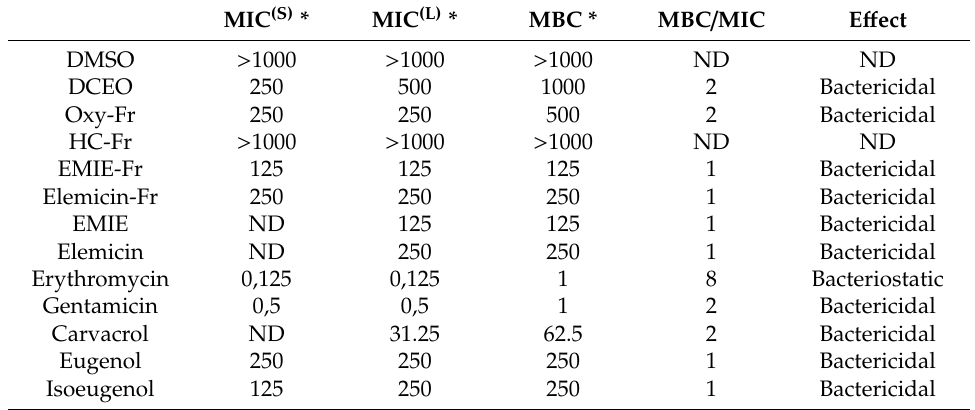
Table 1. Susceptibility and type of antibacterial e ff ect of the DCEO, the DCEO fractions, and synthesized molecules against the C. jejuni F38011 strain. Data resulted from three independent